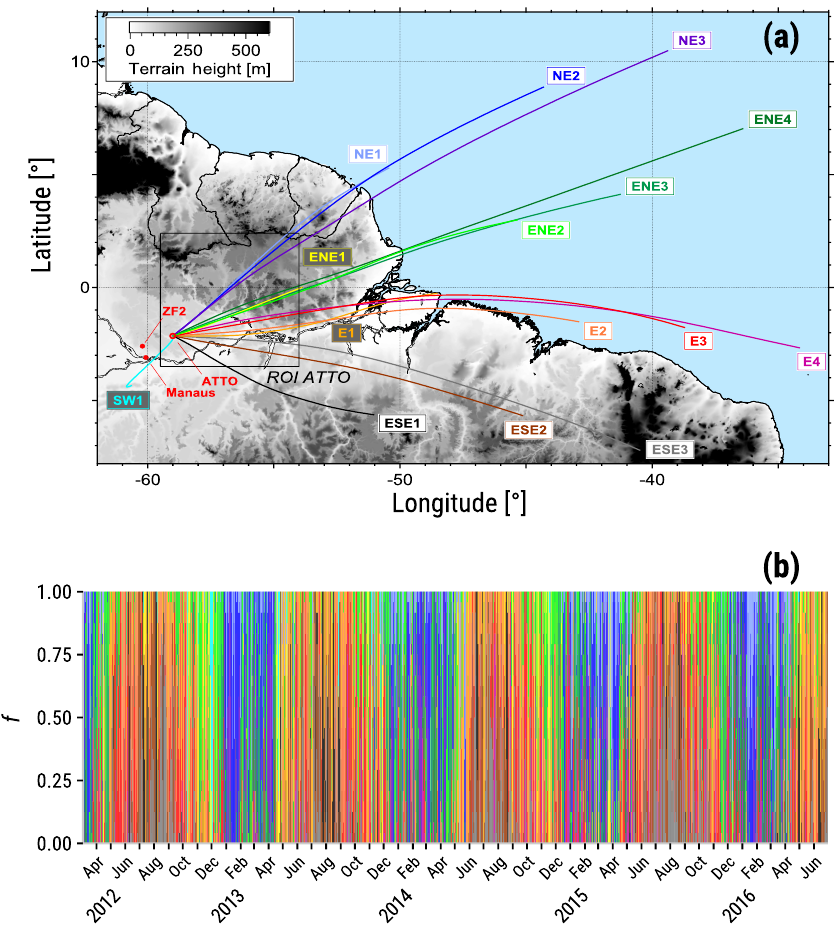
Figure 1. (a) Map of the northeastern Amazon Basin including averaged backward trajectory clusters and the region of interest (ROI) (59– 54 ◦ W; 3.5 ◦ S–2.4 ◦ N), as a black rectangle, used to retrieve precipitation in the ATTO area. (b) Time series of the frequency of occurrence of each BT cluster during the sampling period. Adapted from C. Pöhlker et al.